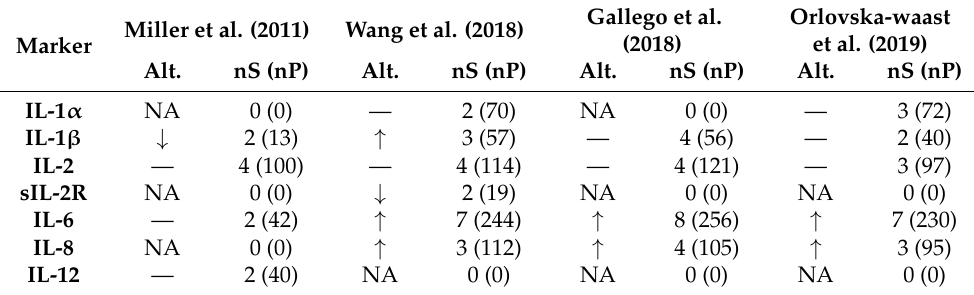
Table 3. Summary of meta-analytical data concerning cerebrospinal fluid cytokine levels in schizophrenia patients as compared to healthy